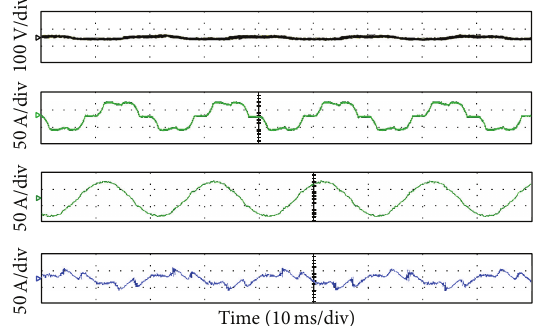
Figure 9: Waves of DC bus voltage, load current, power grid current, and APF compensation current.